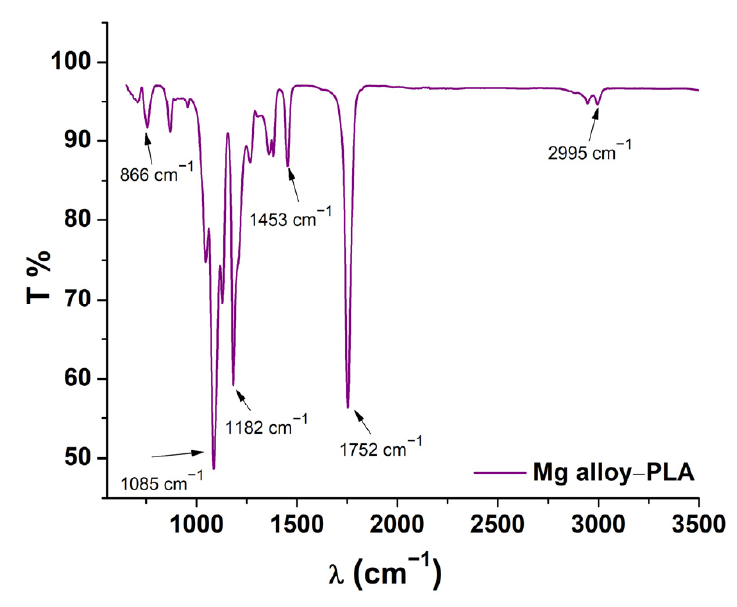
Figure 1. FT-IR spectrum of polylactic acid.